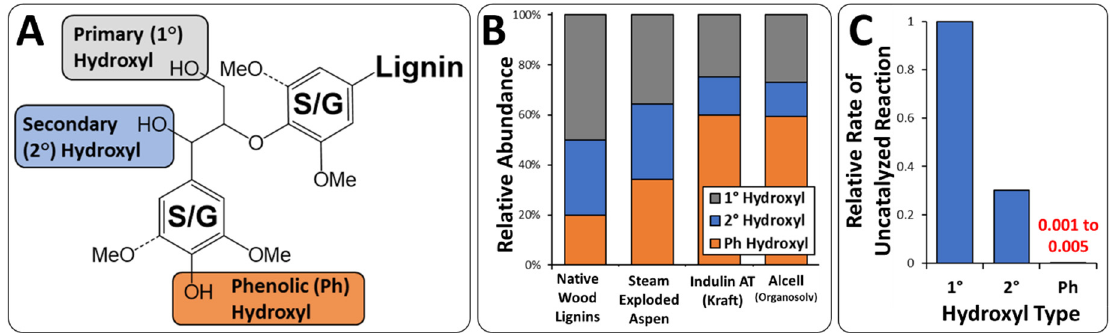
Figure 2. Identification of di ff erent pools of hydroxyl groups ( A ), their alteration ( B ) during processing based on [36,37] and ( C ) relative rate of reaction of an alcohol with an isocyanate based on [12].